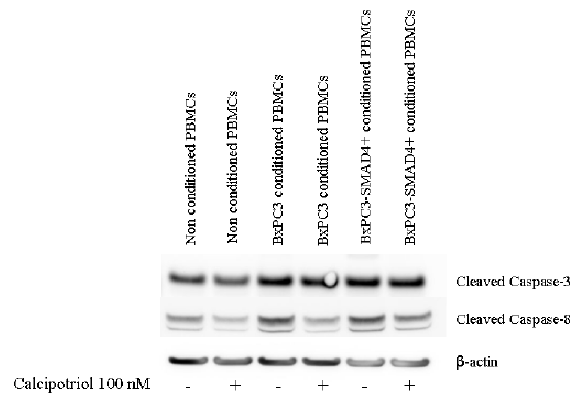
Figure 6. Western blot analyses obtained from PBMCs cultured or not cultured with BxPC3 or BxPC3- SMAD4 + conditioned media in the presence or in the absence of 100 nM calcipotriol. Representative targets of Caspase pathway is shown.